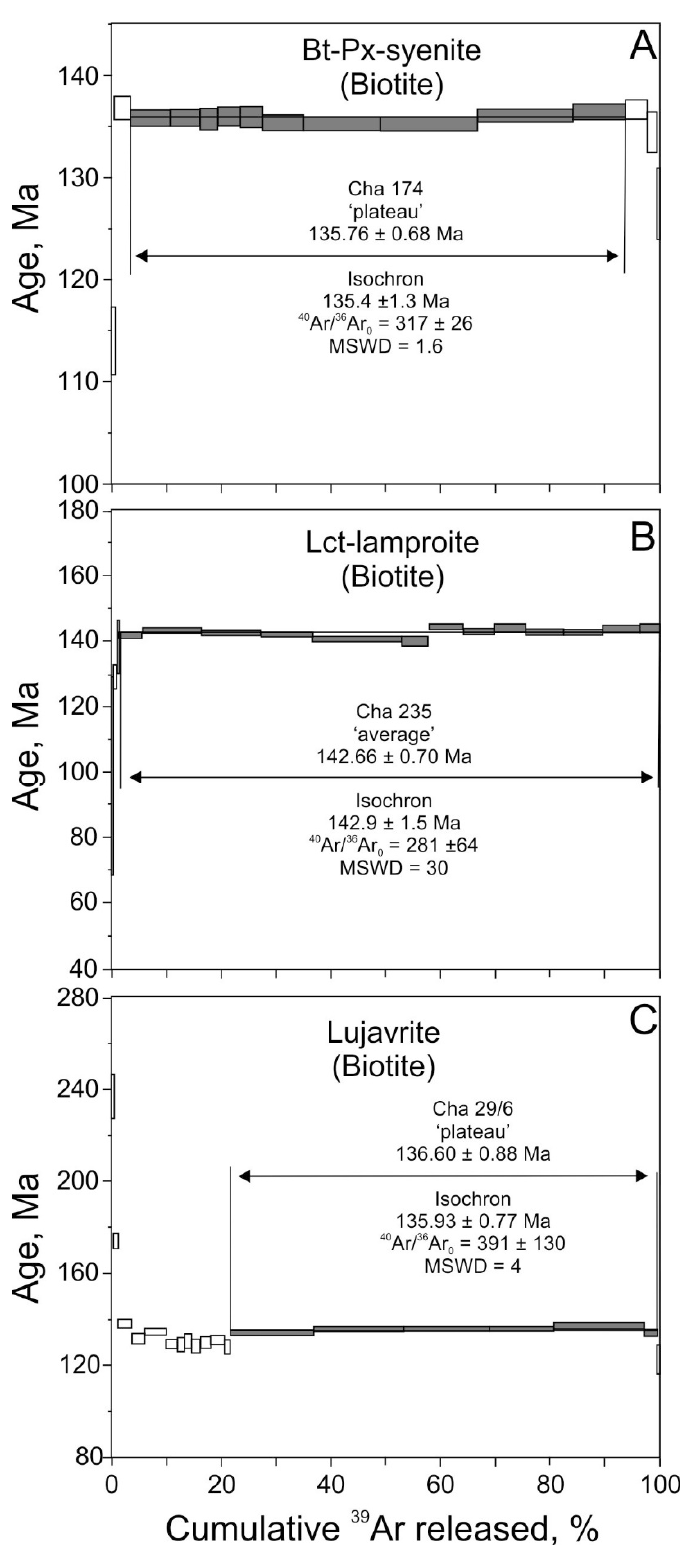
Figure 6. Argon release spectra for intrusions and lava of the main and volcanic stages: ( A ) Sample Cha174—biotite-pyroxene-syenite; ( B ) sample Cha235—leucite lamproite; and ( C ) sample Cha29/6—lujavrite. Steps used for calculation of plateau, average, and isochron age values are shadowed.